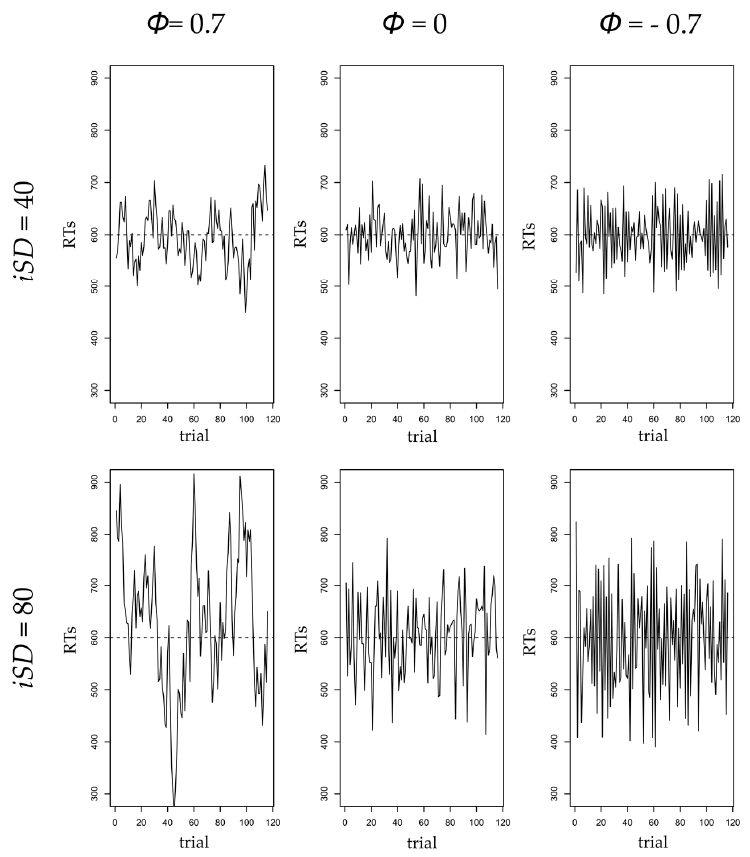
Figure 1. Simulated distributions of time series as a function of the values of the autoregressive parameter ( φ , representing the time-structured component of intraindividual variation, IIV) and amplitude of fluctuation (intraindividual standard deviation, iSD , representing net IIV). From left to right, column panels represent time series for a positive ( φ = 0.7), null ( φ = 0), and negative ( φ = − 0.7) autoregressive parameter. Top line panel represents time series for low amplitude of fluctuations ( iSD = 40), and bottom line panel represents time series for a high amplitude of fluctuations ( iSD = 80). Mean reaction time (RT) = 600 ms does not vary across time series.